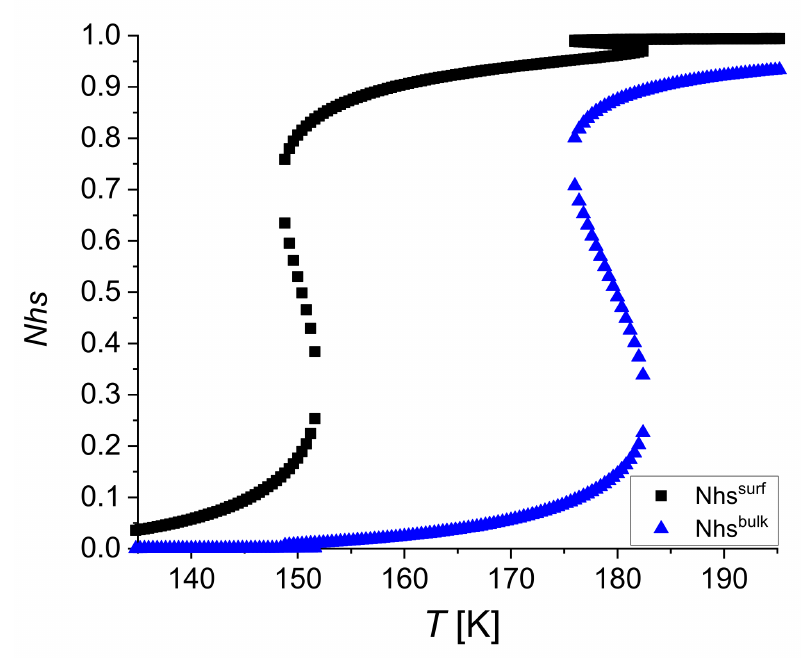
Figure 4. Thermal evolution of the HS fraction in an SCO system with size 6 × 6. Black squares: surface variation; Blue up-triangles: bulk variation. The calculation parameters are: ∆ / k B = 1300 K, G / k B = 172 K, J bb / k B = 60 K, J ss / k B = 50 K, J bs / k B = 20 K, L / k B = 290 K, and ln( g ) =